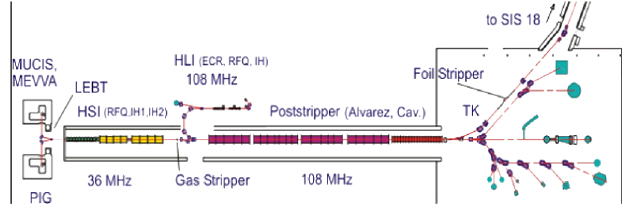
FIG. 7. The universal linear accelerator (UNILAC) at